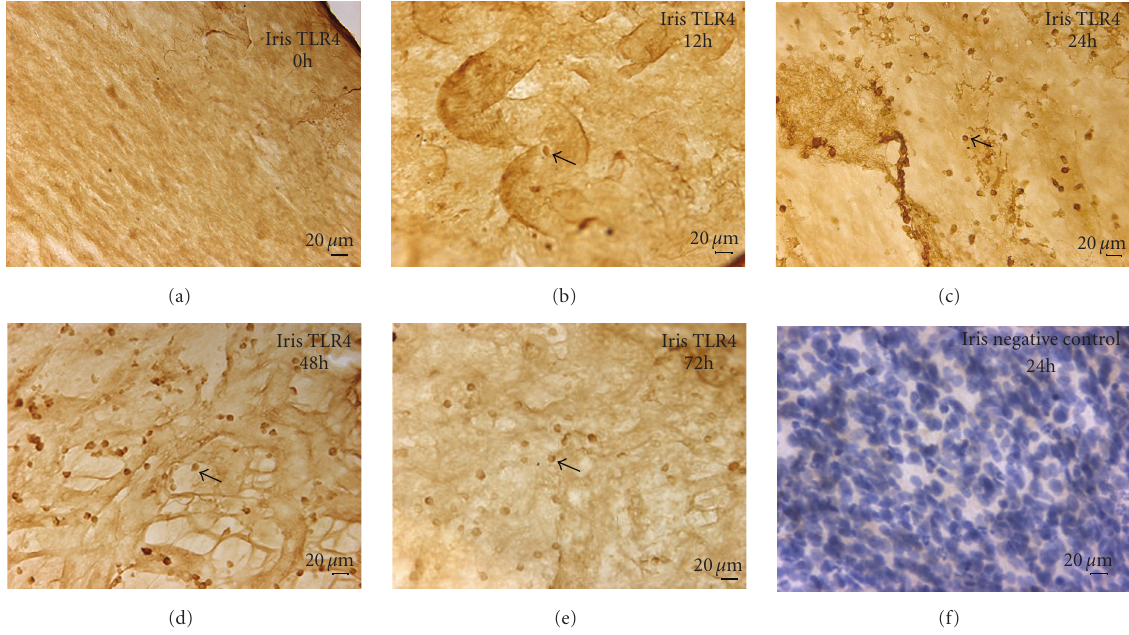
Figure 4: Immunohistochemistry of TLR4 (DAB): (a) TLR4 could not be detected in the iris at 0h. (b) The TLR4 located adjacent to blood vessels in the iris at 12h. (c) Most of TLR4 expressed in the iris at 24h. (d) The TLR4 positive cells were shown at 48 h. (e) TLR4 positive cells had been decreased in the iris at 72 h (Bar = 20 μ m). (f) No positive staining was observed in the iris with a nuclear counterstain when under identical experimental conditions when replacing of the primary antibody with normal rabbit IgG at the same concentration (negative control, Bar = 10 μ